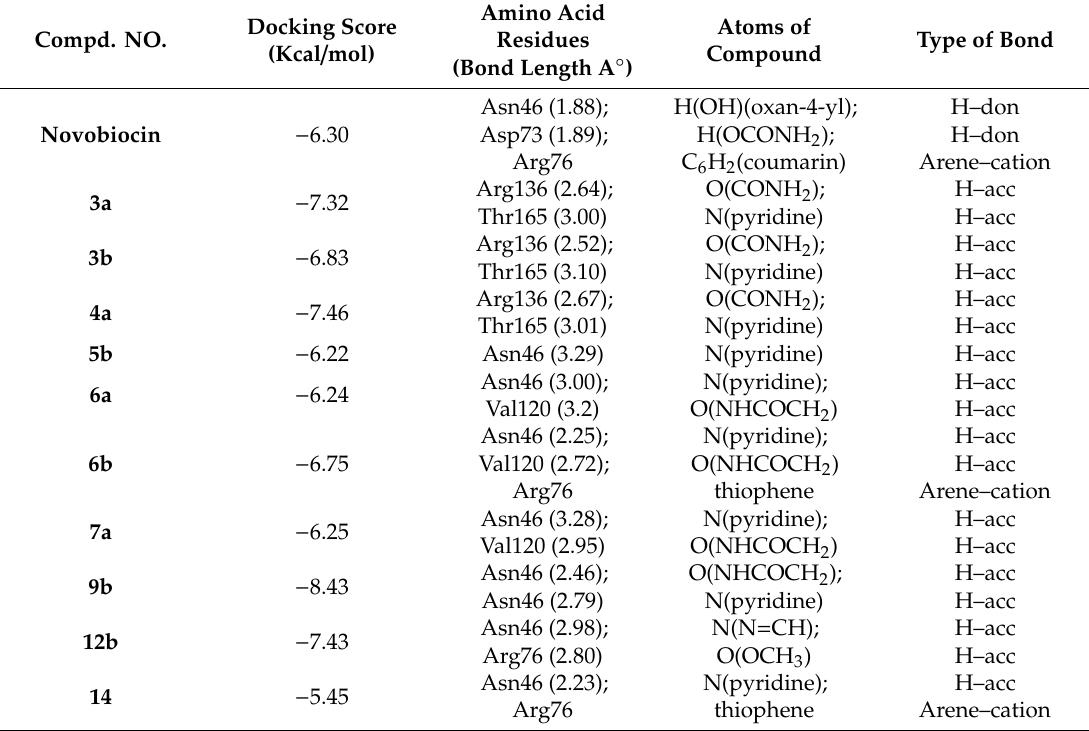
Table 4. Docking results of the compounds ( 3a,b, 4a, 5b, 6a,b, 7a, 9b, 12b, and 14 ) with E. coli DNA gyrase B kinase using MOE software version